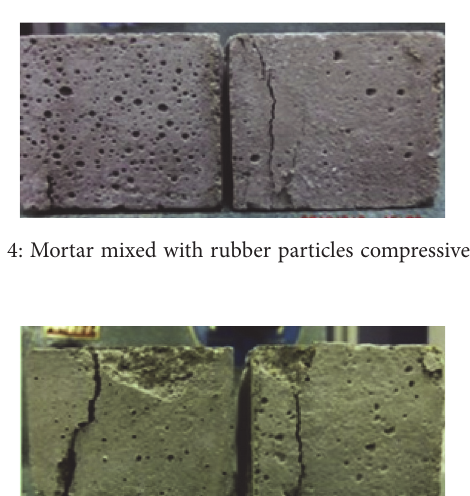
Figure 2: 28 d flexural strength of cement mortar with different amount of 60-mesh rubber particles.